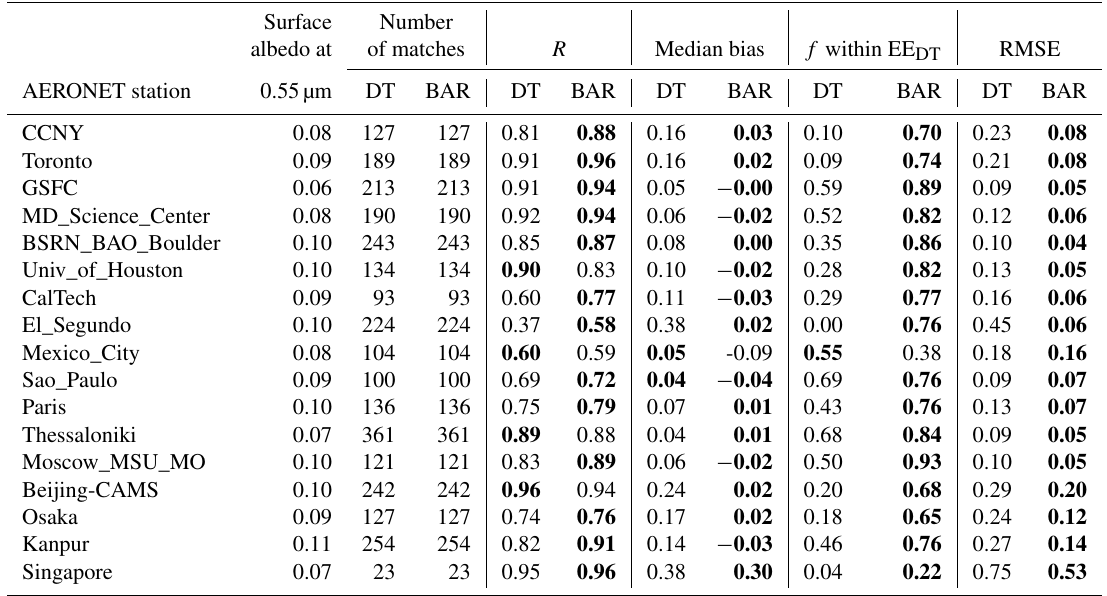
Table 7. Statistics of AOD retrievals for Dark Target (DT) and Bayesian aerosol retrieval (BAR) algorithms over urban AERONET stations. The location information for the AERONET sites can be found at the AERONET web page https://aeronet.gsfc.nasa.gov/.